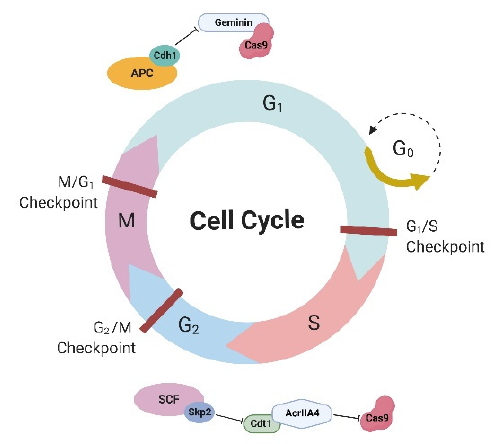
Figure 1. Factors providing Cas9 expression in a cell cycle-dependent manner. Fusion of Cas9 with geminin resulted in lower expression of Cas9 in G1 and higher expression in S/G2/M phases because of degradation by APC-Cdh1. Since Cdt1 is active in the G1 phase, the AcrIIA4-hCdt1 complex in- hibits Cas9 in the G1 phase; in the S/G2 phases, the complex undergoes proteolysis by the SCF-Skp2 complex and releases Cas9 activity. APC—anaphase-promoting complex, Cdh1—Cadherin-1, hCdt1—human chromatin licensing and DNA replication factor 1, SCF—Skp1-Cul1/Cdc53-F-box protein. Detailed explanations are provided in the